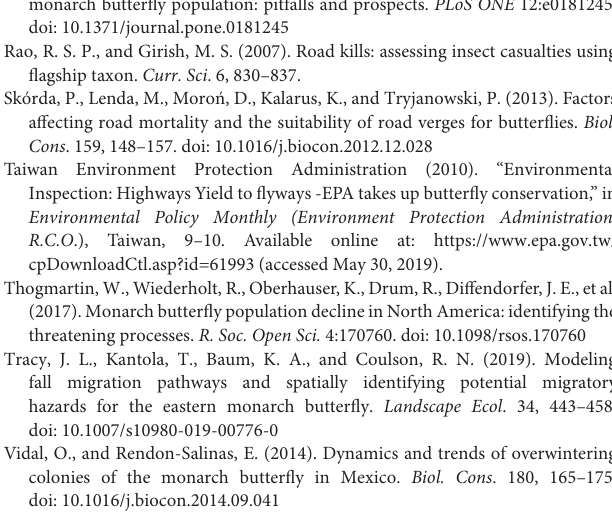
creating Figure 1 . The manuscript benefitted from the reviews of Ryan Drum and two reviewers.